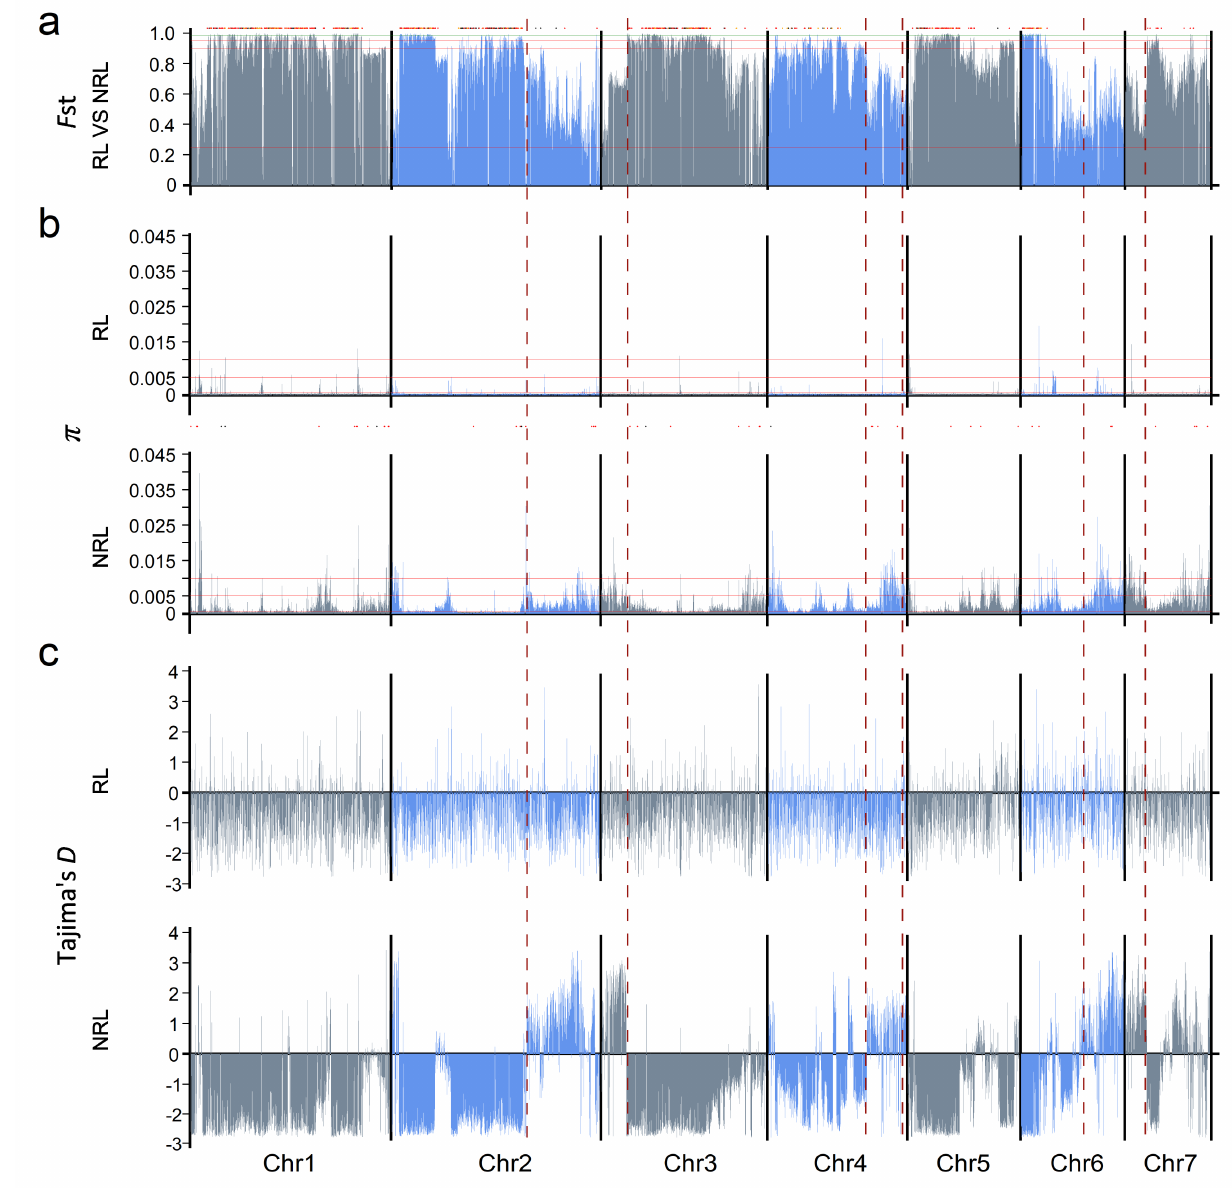
Figure 1. Genome–wide view in 10 kb windows of differentiation ( F st ), diversity ( π ) and Tajima’s D . ( a ) The F st compared between RL and NRL. The RL included 24 rice-infecting isolates with the largest ungapped length of genome in NCBI database, and the NRL included 14 wheat-, 8 Lolium and 2 Bromus -infecting isolates. The locations of 856 genes mutated by S-SNPs were showed at the top of F st . The orange dot indicated that there was at least one S-SNP is in CDS, the red dot indicated that non-synonymous substitutions had occurred in CDS, and the black dot indicated that all S-SNPs were located in intron or untranslated region. The distributions of π ( b ) and Tajima’s D ( c ) of RL and NRL. The area sandwiched by the red dotted line in the vertical direction represented the area enriched by window of Tajima’s D < 0 in NRL. In these regions, the π of NRL increased while the Fst between RL and NRL decreased. The dots between π of RL and NRL in ( b ) were the favorable genes present in 70-15. Among them, red and black indicated favorable genes of RL and NRL